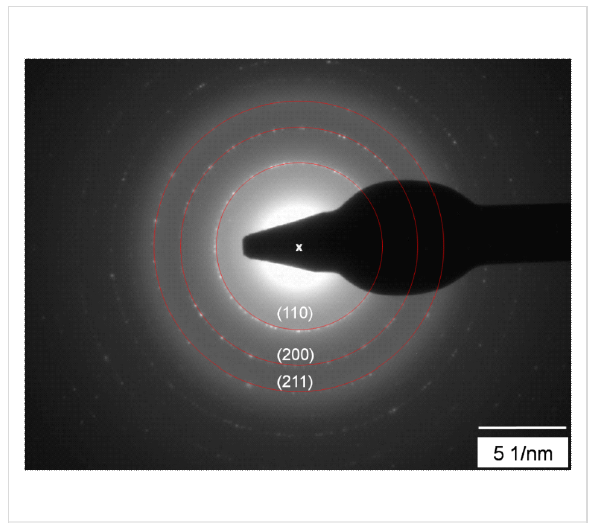
Figure 3: Electron diffraction pattern of the Fe nanoparticles. The Miller indices of the respective lattice planes belong to the bcc struc- ture of Fe.